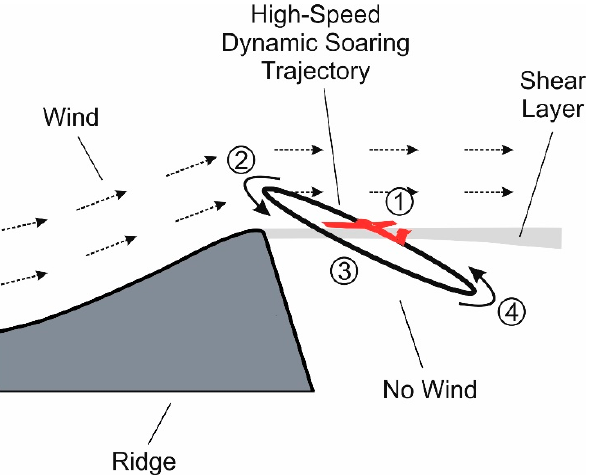
Figure 1. High-speed dynamic soaring trajectory and shear wind scenario at ridge.